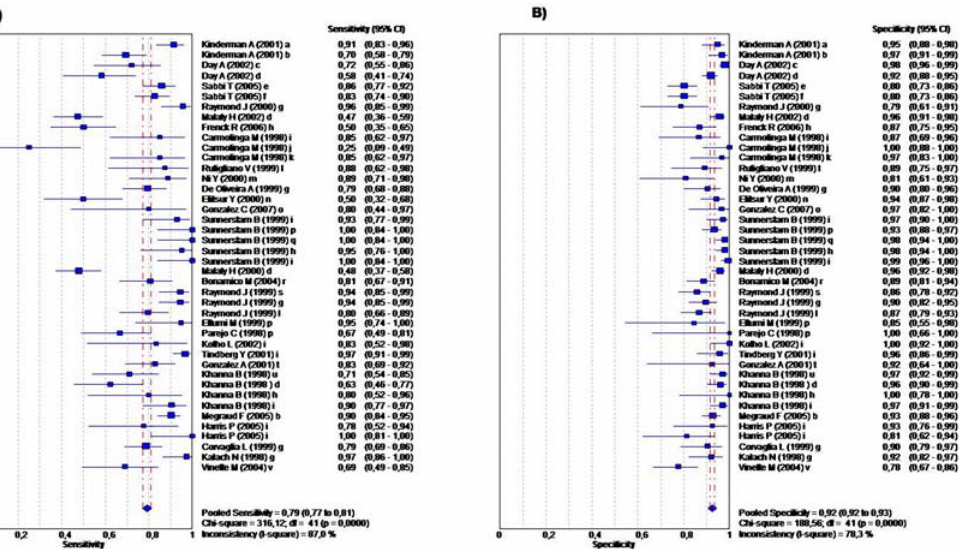
Figure 2. Forest Plot for the Sensitivity and Specificity of the Serum IgG-ELISA Diagnostic Tests. The squares and lines represent the point estimates and 95% CIs, respectively. The size of square indicates the study size. The pooled estimated is denoted by a diamond at the bottom. a=Enzygnost II, b=Pyloritest, c=MedMira; d=FlexSure, e=Eurospital, f=Eurospital-CagA, g=Cobas II, h=HM-CAP, i=In-house WC, j=In-house Urease, k=In-house CagA, l=GAP-Test, m=HEL-p II, n=Cobas I, o=InmunoLISA, p=Helico-G, q=Pyloriset, r=Helory, s=Platelia, t=Immulite, u=PyloriStat,